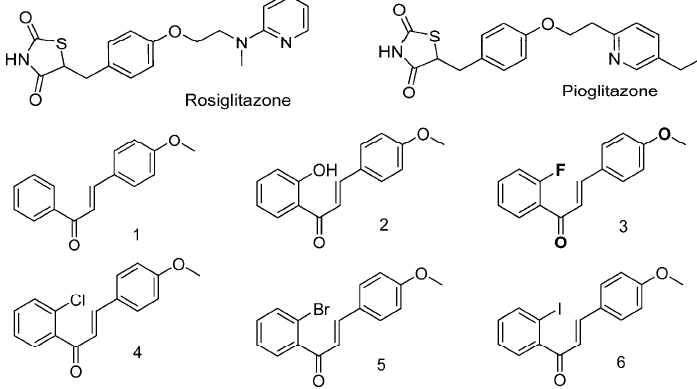
Figure 1. Chemical structures of rosiglitazone, pioglitazone, and chalcone derivatives.